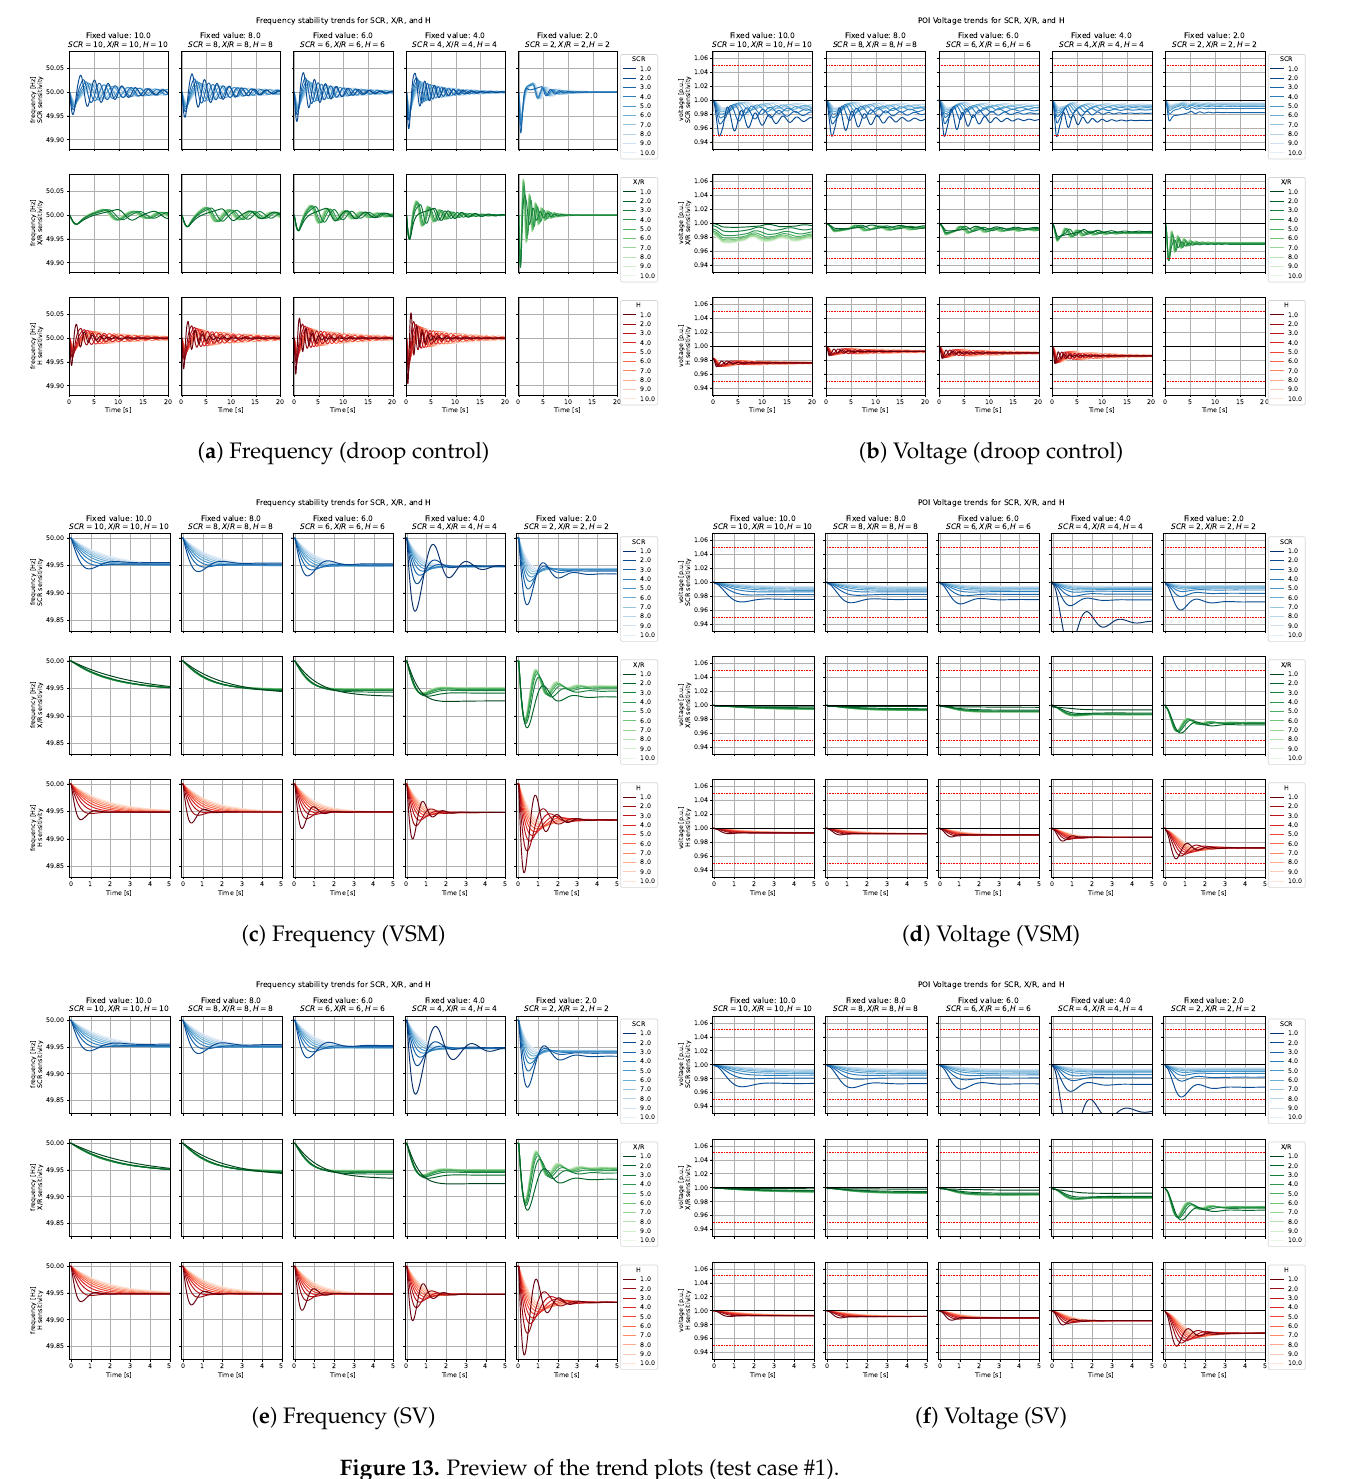
Figure 13. Preview of the trend plots (test case